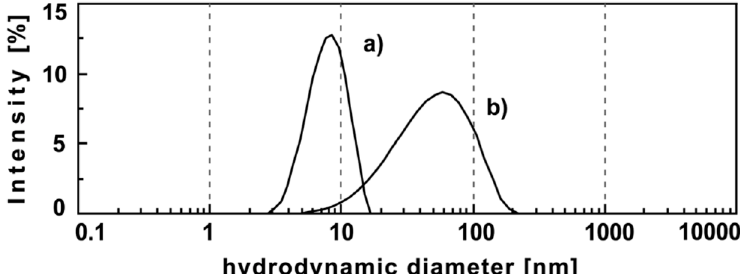
Figure 1. Hydrodynamic diameter of particles in as-prepared MgF 2 sols ( a ) and in samples after boiling for 24 h ( b ) as measured by dynamic light scattering. Reproduced from Reference [36] with the permission of the Royal Chemical Society.